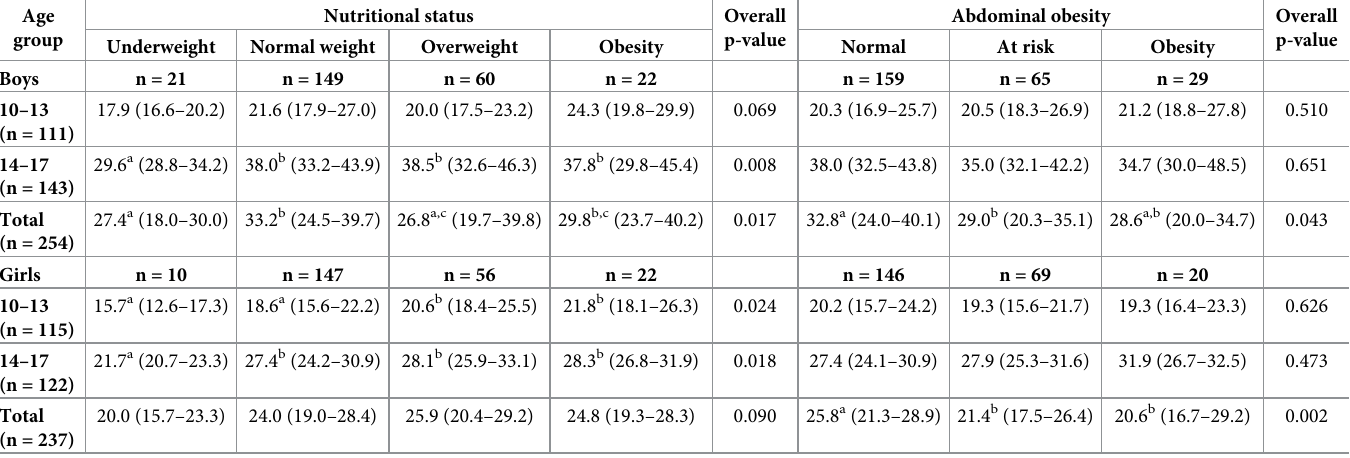
Table 3. Maximum strength of dominant hand by age group, nutritional status and abdominal obesity, stratified by sex. Age Nutritional group